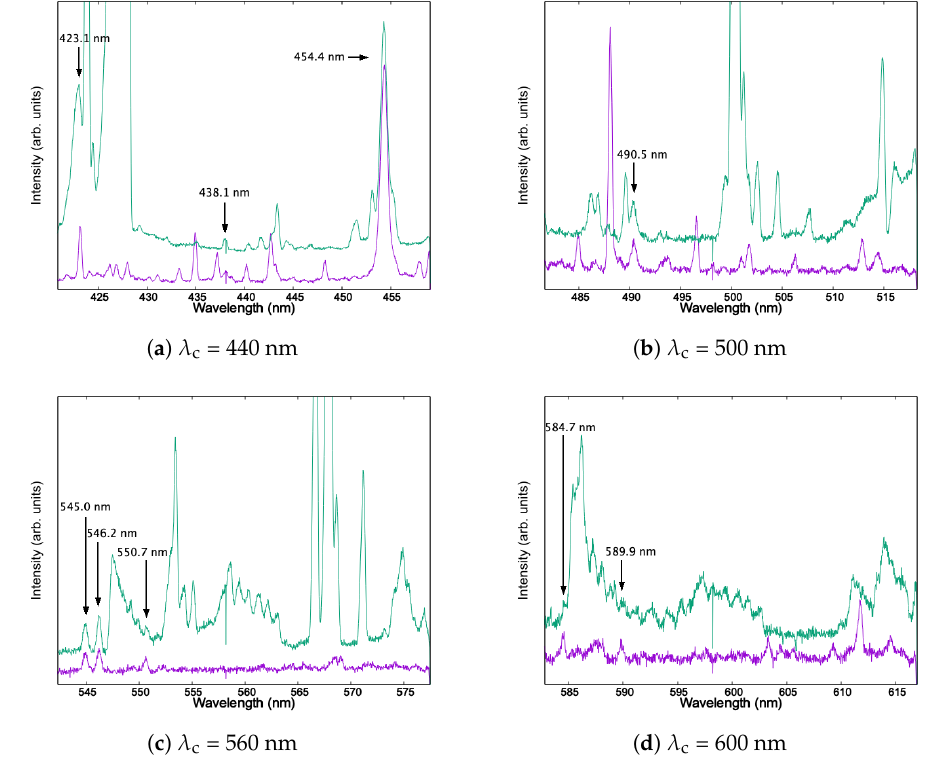
Figure 2. Visible emission spectra of radiation resulting from the collisions of Er 5 + ions with Ar (purple) and N 2 (green) targets at an energy of 75